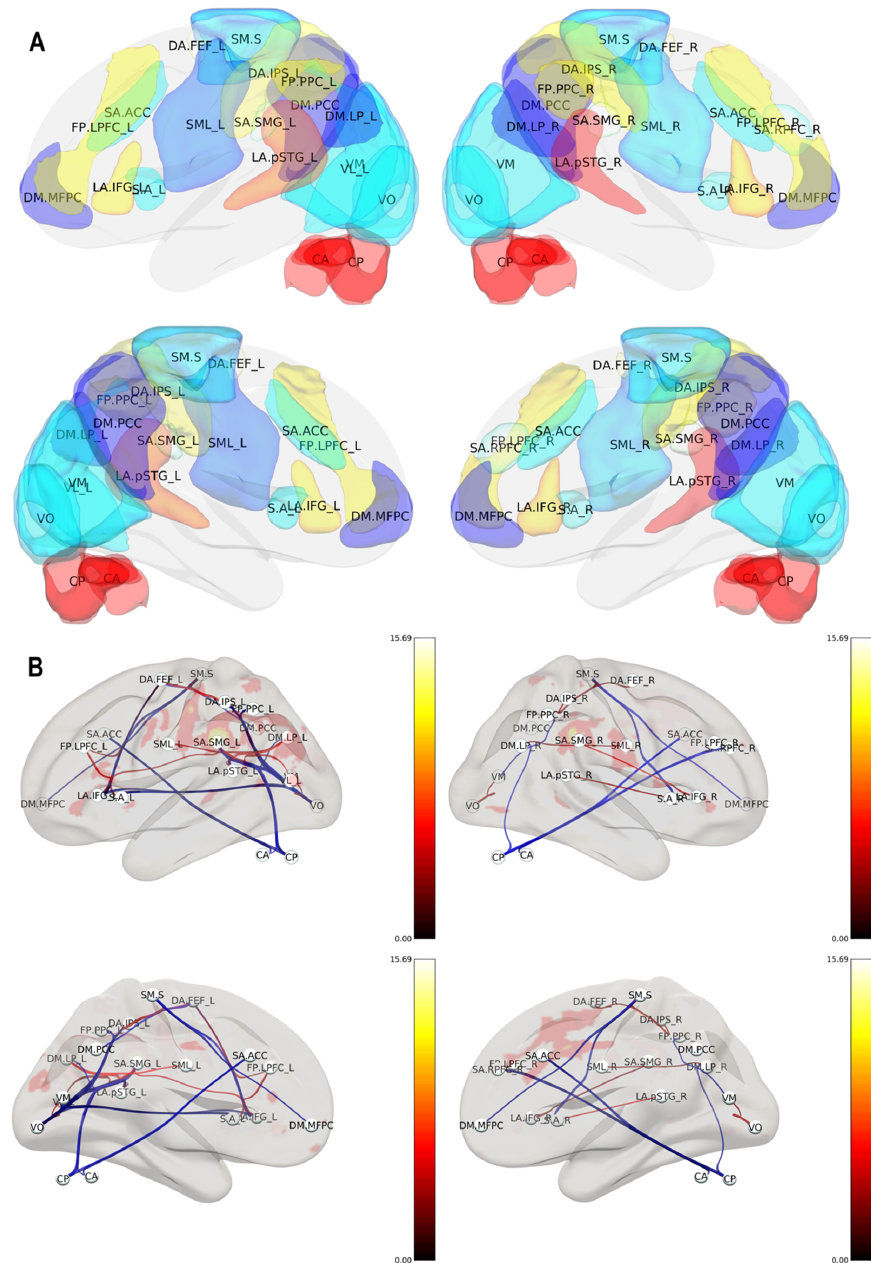
Figure 4. 3D color brain maps showing ( A ) several functional RSNs, such as the language, visual, and sensorimotor network, with precise cortical parcellation identification. Different RSNs depict specific functions and ( B ) their functional connection.